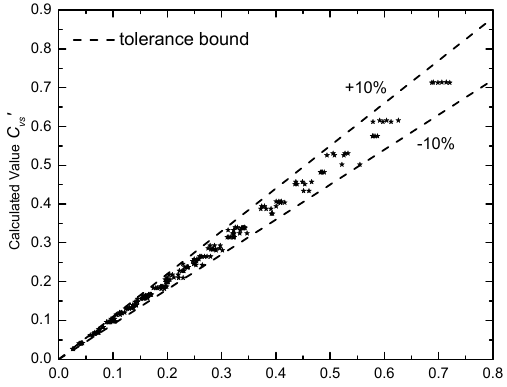
Figure 13. Tolerance between calculated C vs ’ and measured C vs for 234 cases.